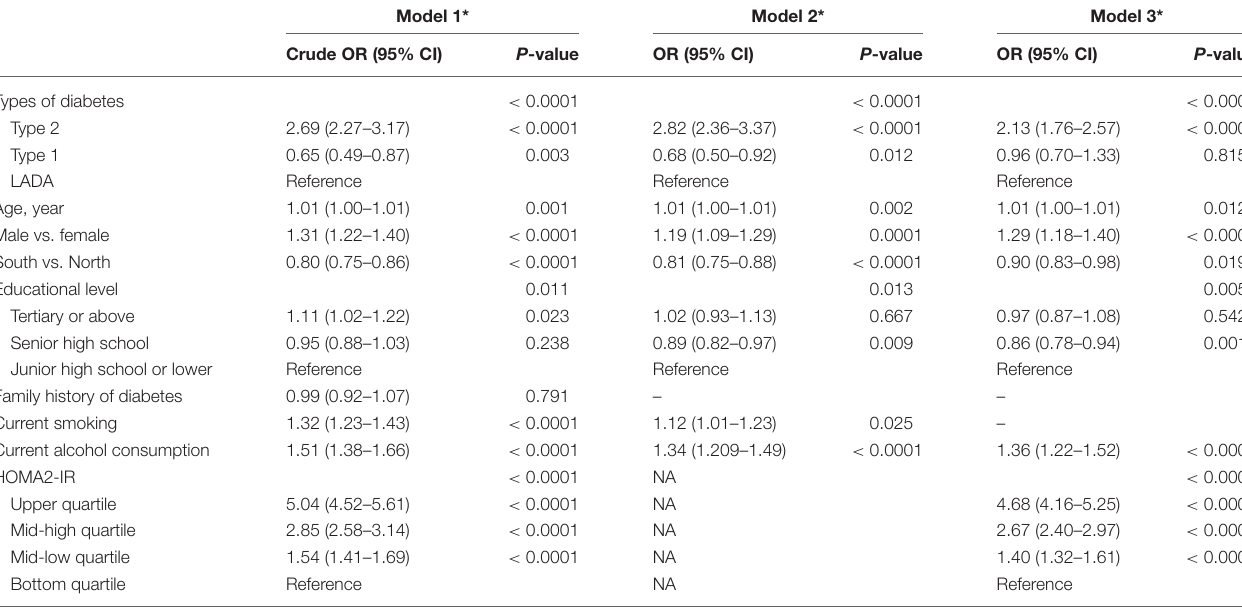
TABLE 2 | Odds ratio of clinical factors for MetS vs. non-MetS in Chinese newly diagnosed diabetes.